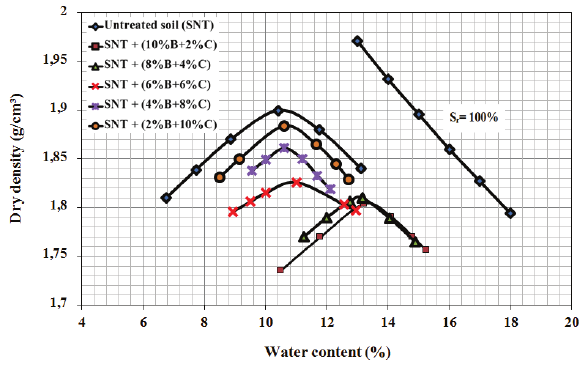
Figure 2: Compaction curves of the untreated and treated soils obtained by wetting.